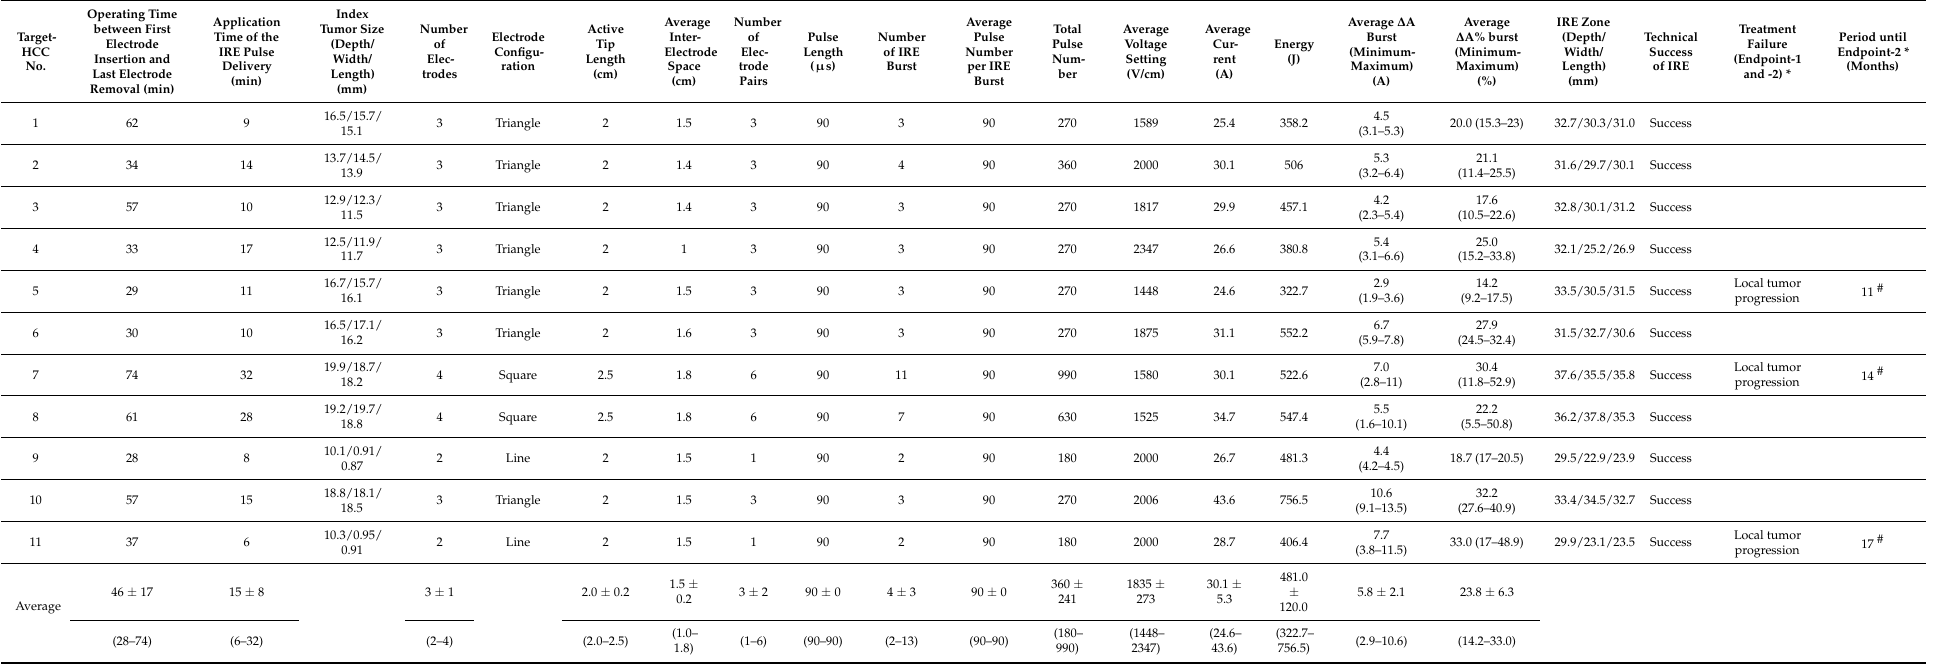
Table 3. Reports of IRE treatment and